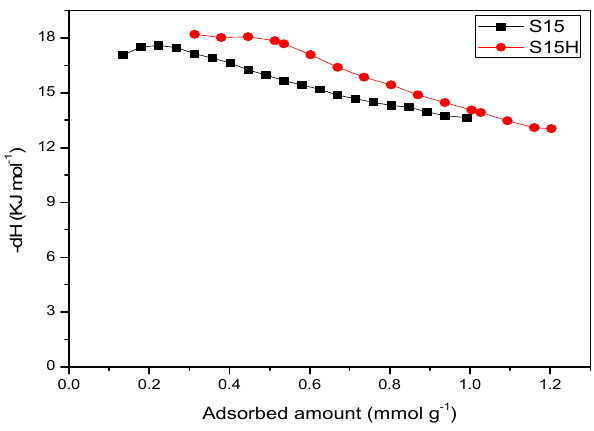
Figure 15. CO 2 adsorption enthalpies of SBA-15 precursor and hydroxylated silicas (S15 and S15H).